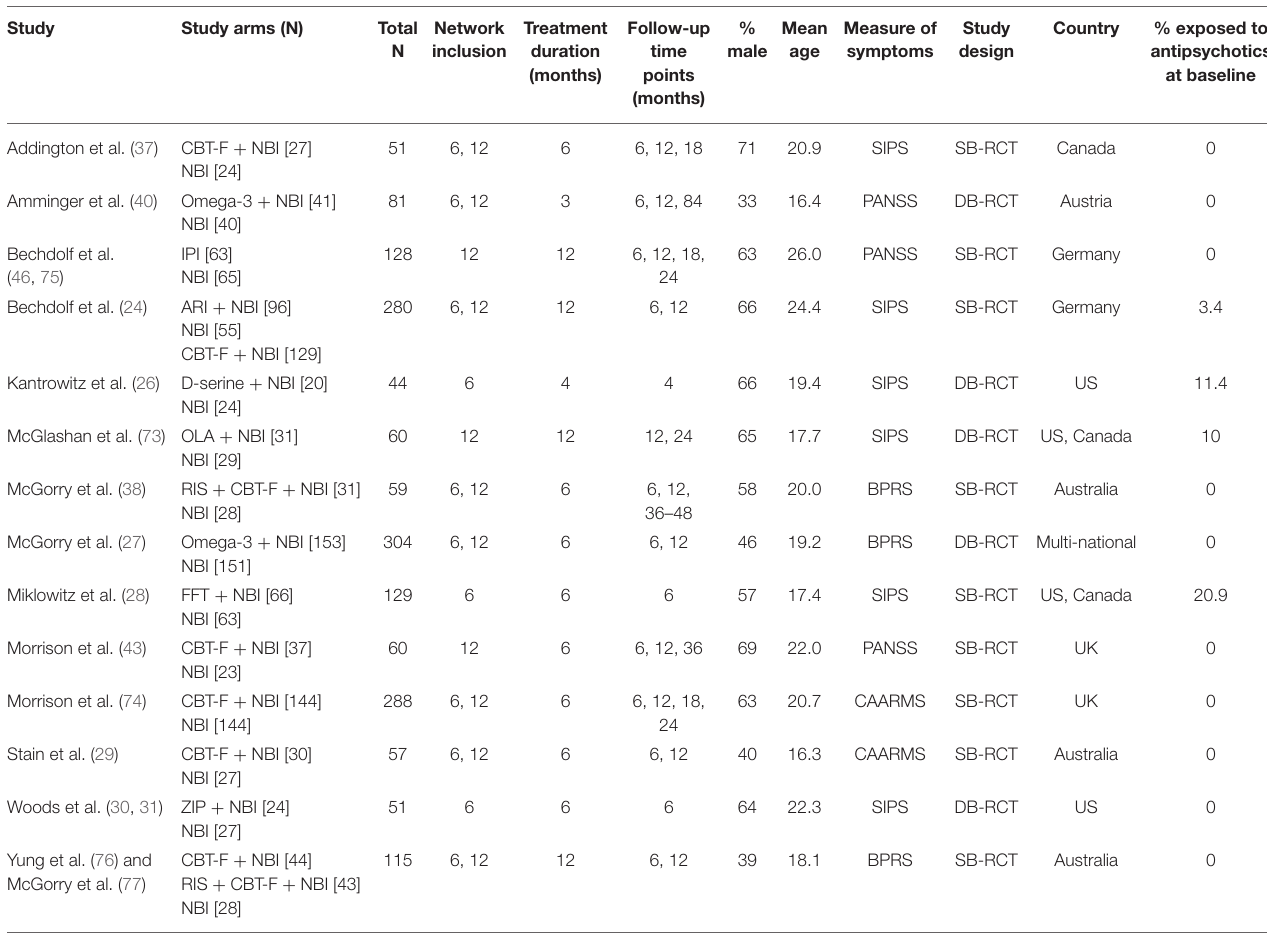
TABLE 1 | Characteristics of included studies. Study Follow-up